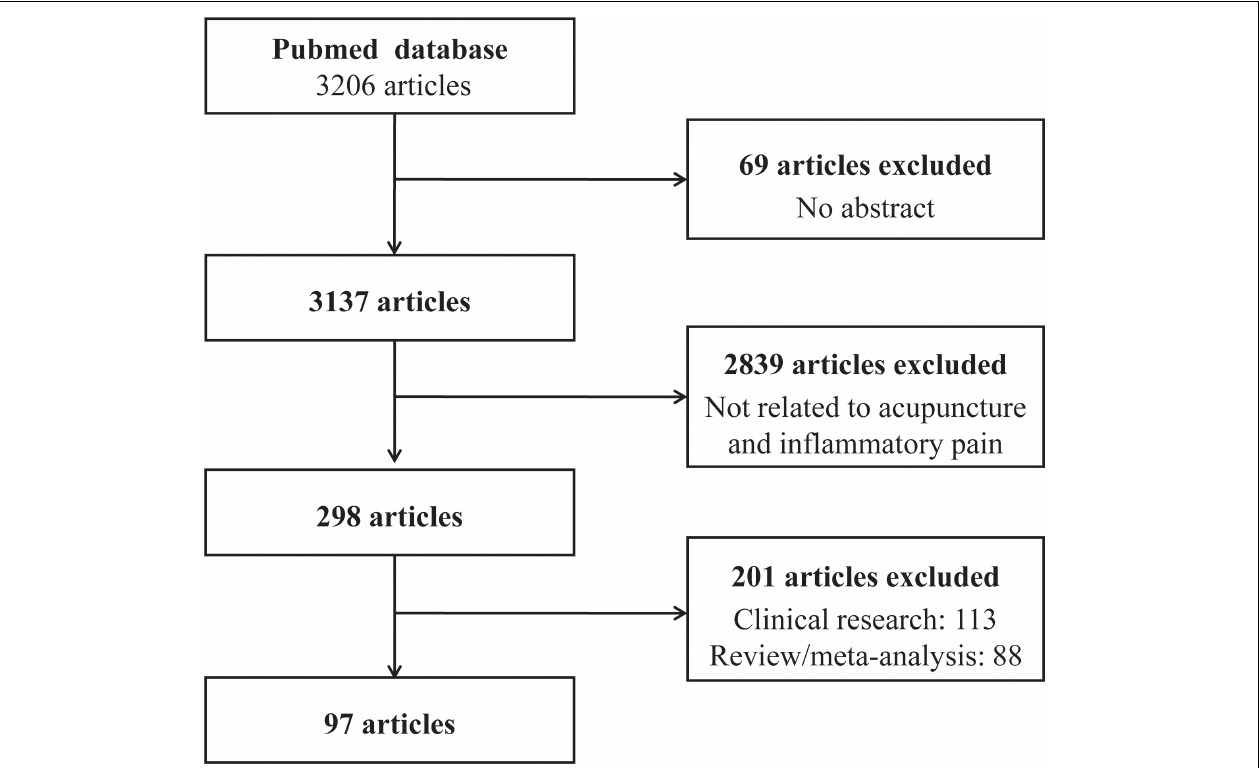
FIGURE 1 | Flow chart of the search strategy and